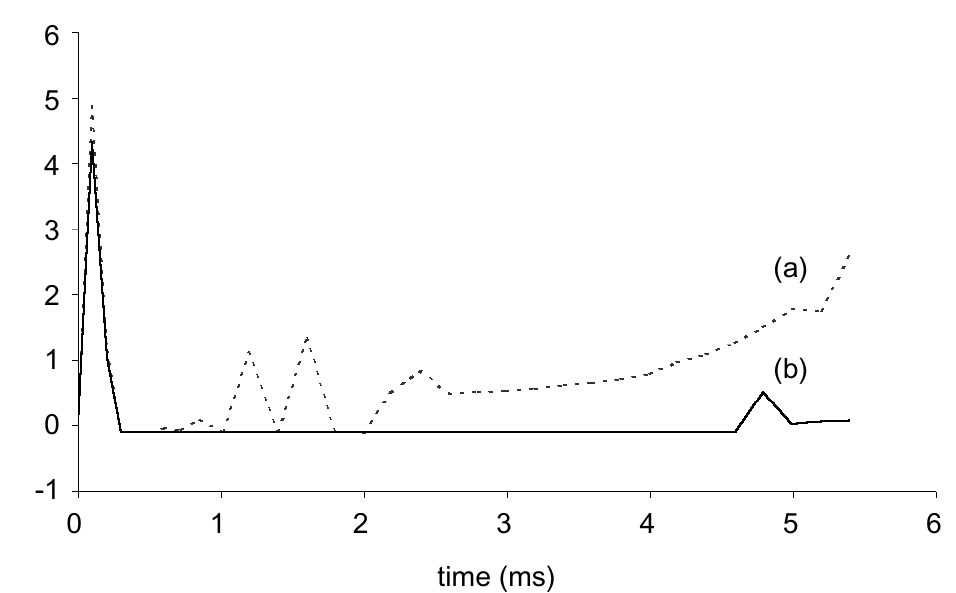
Fig. 8. Finite element pressure-time profiles for the fluid element adjacent to the centre of the 3 mm test plate for (a) Model #2 (i.e. not hydrostatically initialised) and (b) Model #3 (i.e. hydrostatically initialised) indicated by the dashed and solid lines,